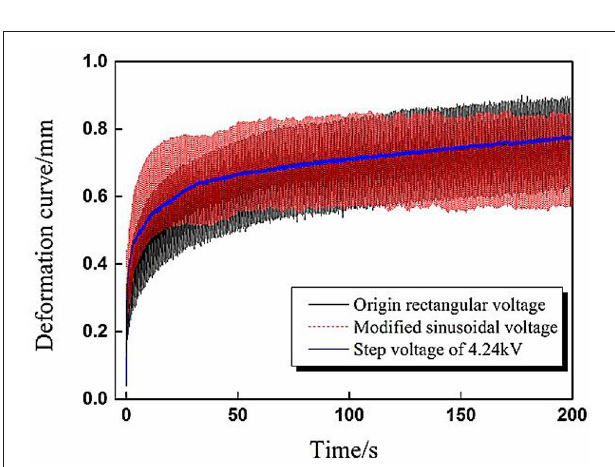
FIGURE 6 | Verification experiment results of dynamic deformation under sinusoidal and rectangular voltages with the same effective voltage value 4.24